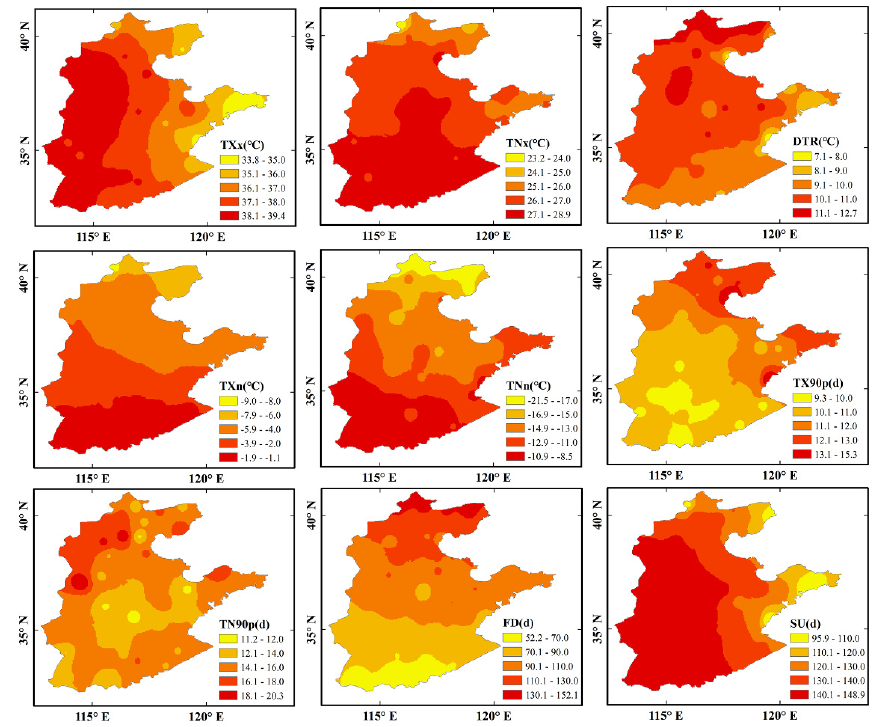
Figure 8. Spatial characteristics of changes in extreme temperature indices in the North China Plain from 2061 to 2100 under the SSP585 scenario.